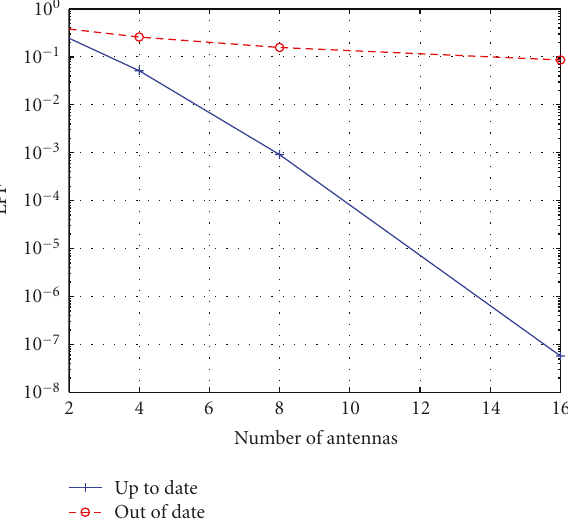
Figure 11: Beamwidth and ESR (for 100 nodes) versus antenna array size. Figure 12: Loss probability due to fading when the estimated channel is out of